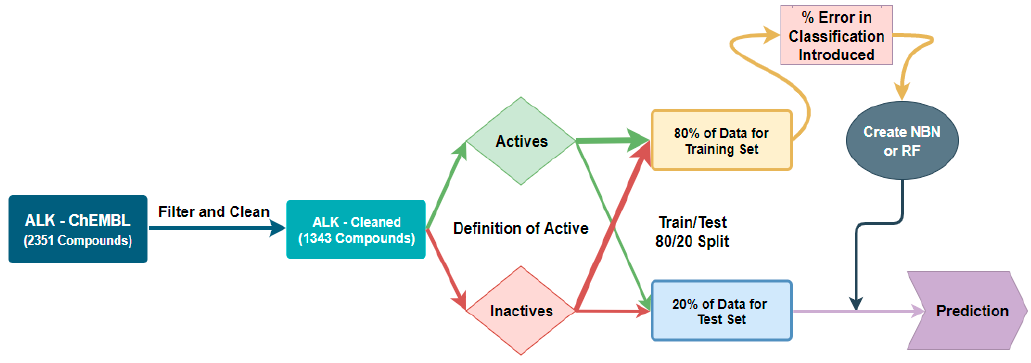
Figure 6. Workflow for error tolerance evaluation in the NBN and RF algorithms.